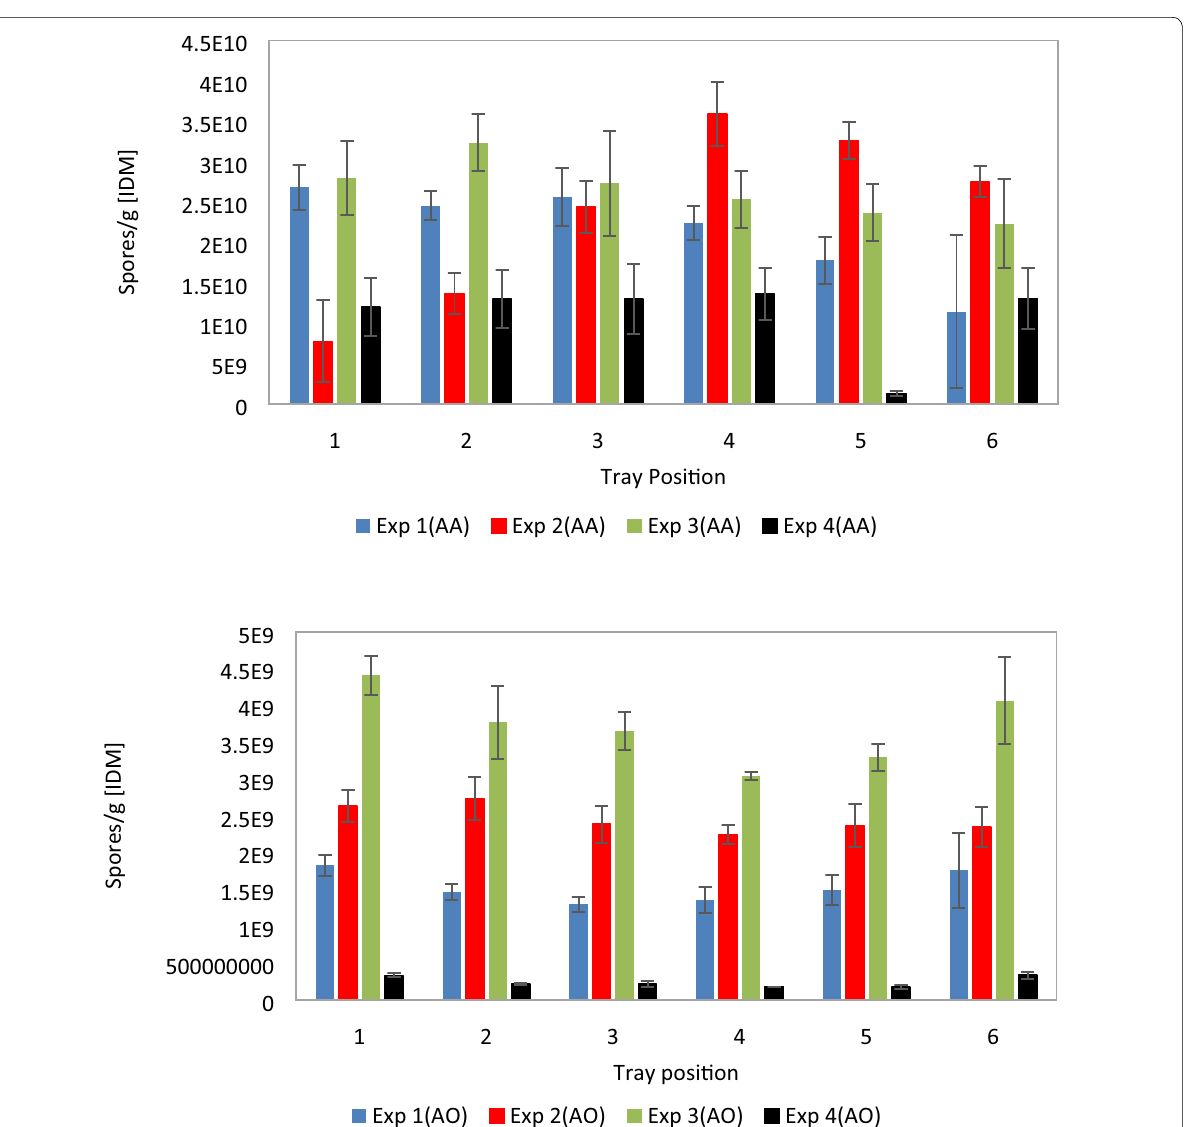
Fig. 8 Fermentation summary of average spores production from multi-stacked circular tray solid-state bioreactor with different moisture content arrangements. [AA]— A. awamori and [AO]— A. oryzae . The results are shown as mean ( n =